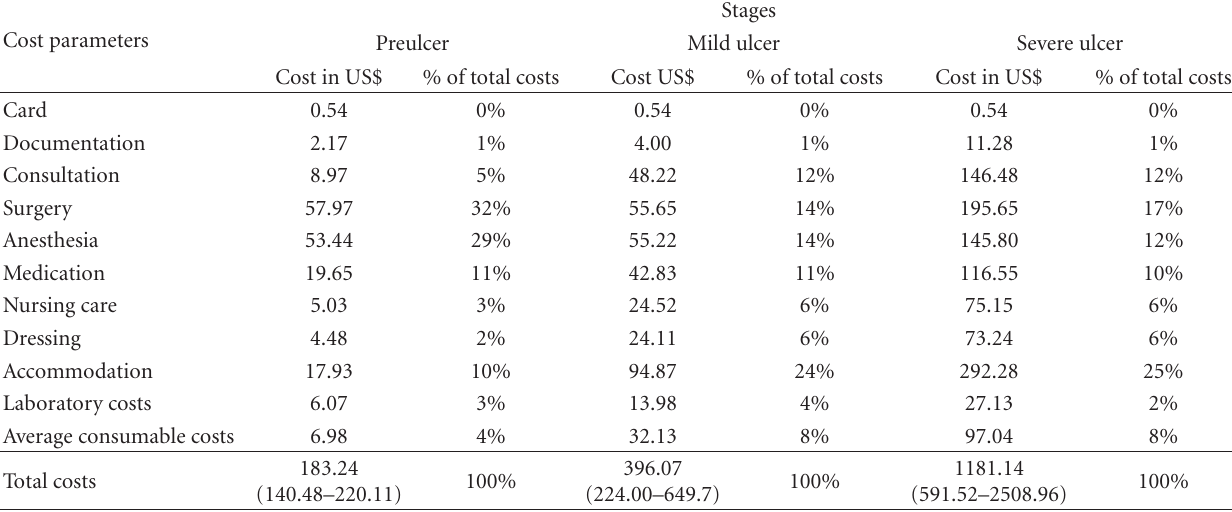
Table 3: Treatment cost distribution for BU patients (in